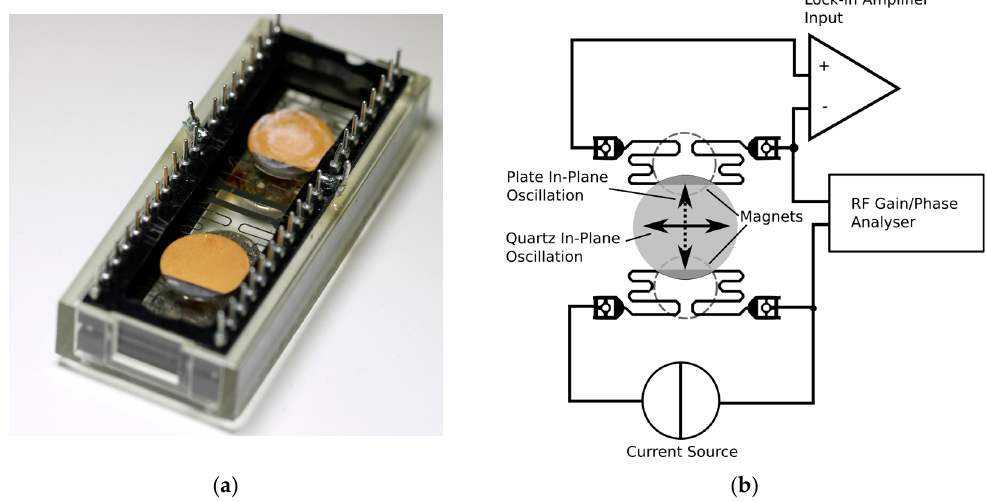
Figure 1. ( a ) Photo of the combined resonator device. The 2.5 MHz (fundamental mode) quartz resonators with around-the-edge electrodes are soldered to the etched Ni-brass support structure. Two identical devices are integrated in a DIL40 housing to facilitate drift compensation; ( b ) Connection scheme for excitation and readout. The low frequency plate resonances are measured using a lock-in amplifier setup with current amplification. The quartz resonances are measured using a RF gain/phase analyser. With the magnetic field aligned perpendicular to the plate, in-plane modes are excited. Using a different orientation of the magnetic field, the plate can alternatively be excited in out-of-plane modes.